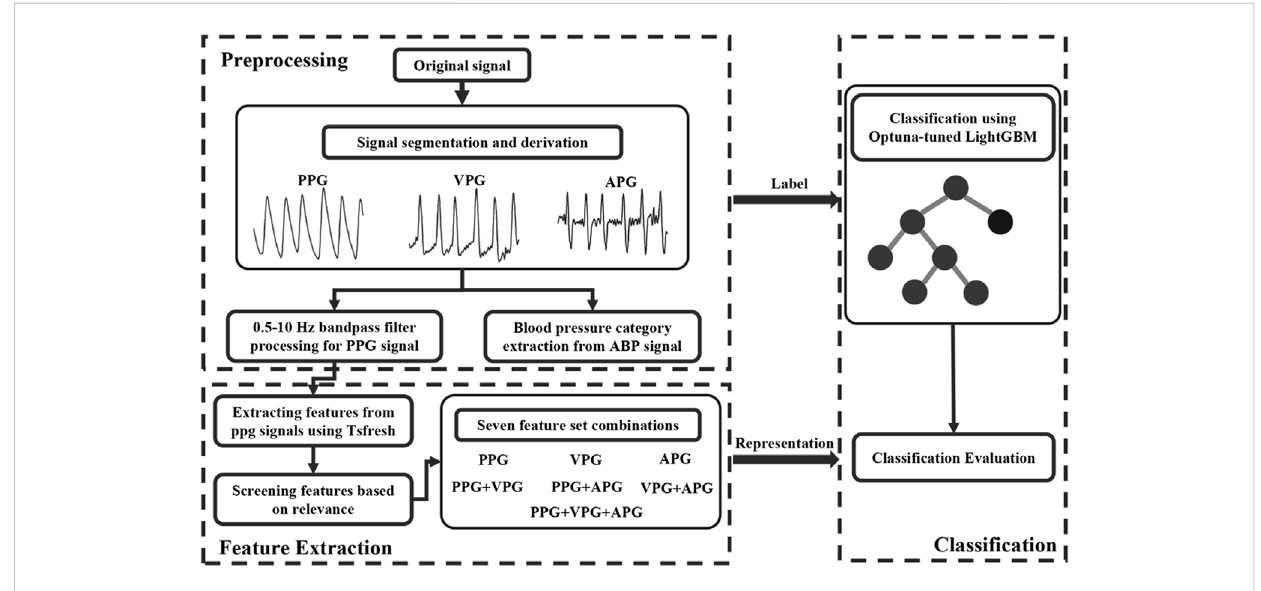
FIGURE 3 the fl ow chart of this study. Note: ABP stands for arterial blood pressure, PPG, VPG, and APG denote photoplethysmography, velocity plethysmography, and acceleration plethysmography, respectively.